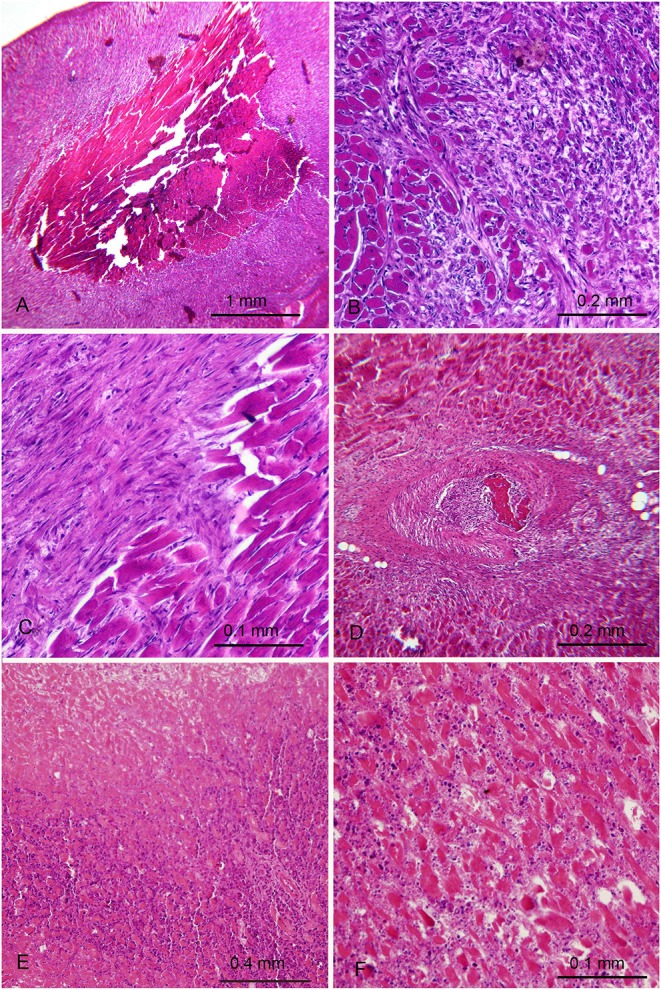
Myocardial lesions in rabbits after parenteral immunization with H. pylori cells occurred months earlier. (A–D) First rabbit with old myocardial infarction with a necrotic mummified core (A) demarcated by granulation tissue (B) with partial transformation in fibrosis (C) and presence of a thrombotic arterial occlusion undergoing organization (D). (E,F) Second rabbit with more recent infarction. (E) necrotic area (top) surrounded by a dense neutrophilic infiltrate (F) A different zone at higher magnification showing eosinophilic necrotic myocytes, edema and significant polymorphonuclear infiltrate.